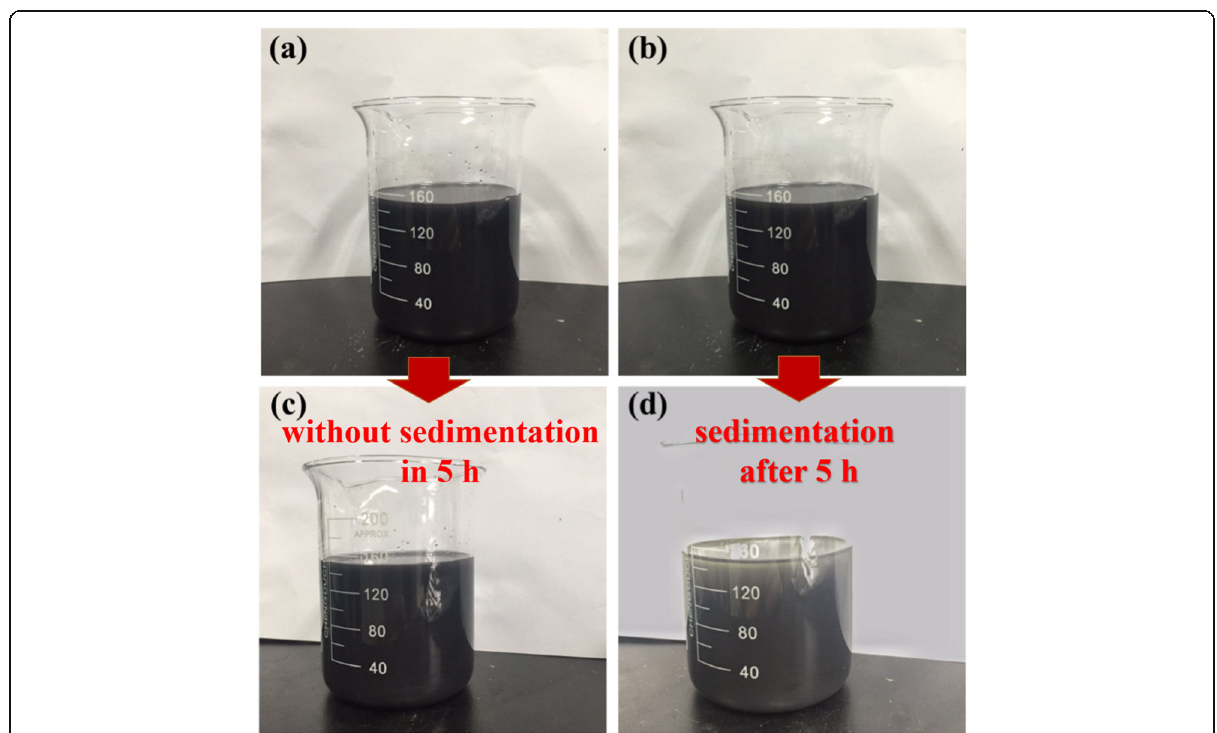
Fig. 6 Digital images of the MoS 2 exfoliated a from the complex solvent (NMP and supercritical CO 2 ) and b from supercritical CO 2 alone, where the obtained MoS 2 are re-dispersed in NMP for observation; and c , d their respective dispersing status after settling for 5